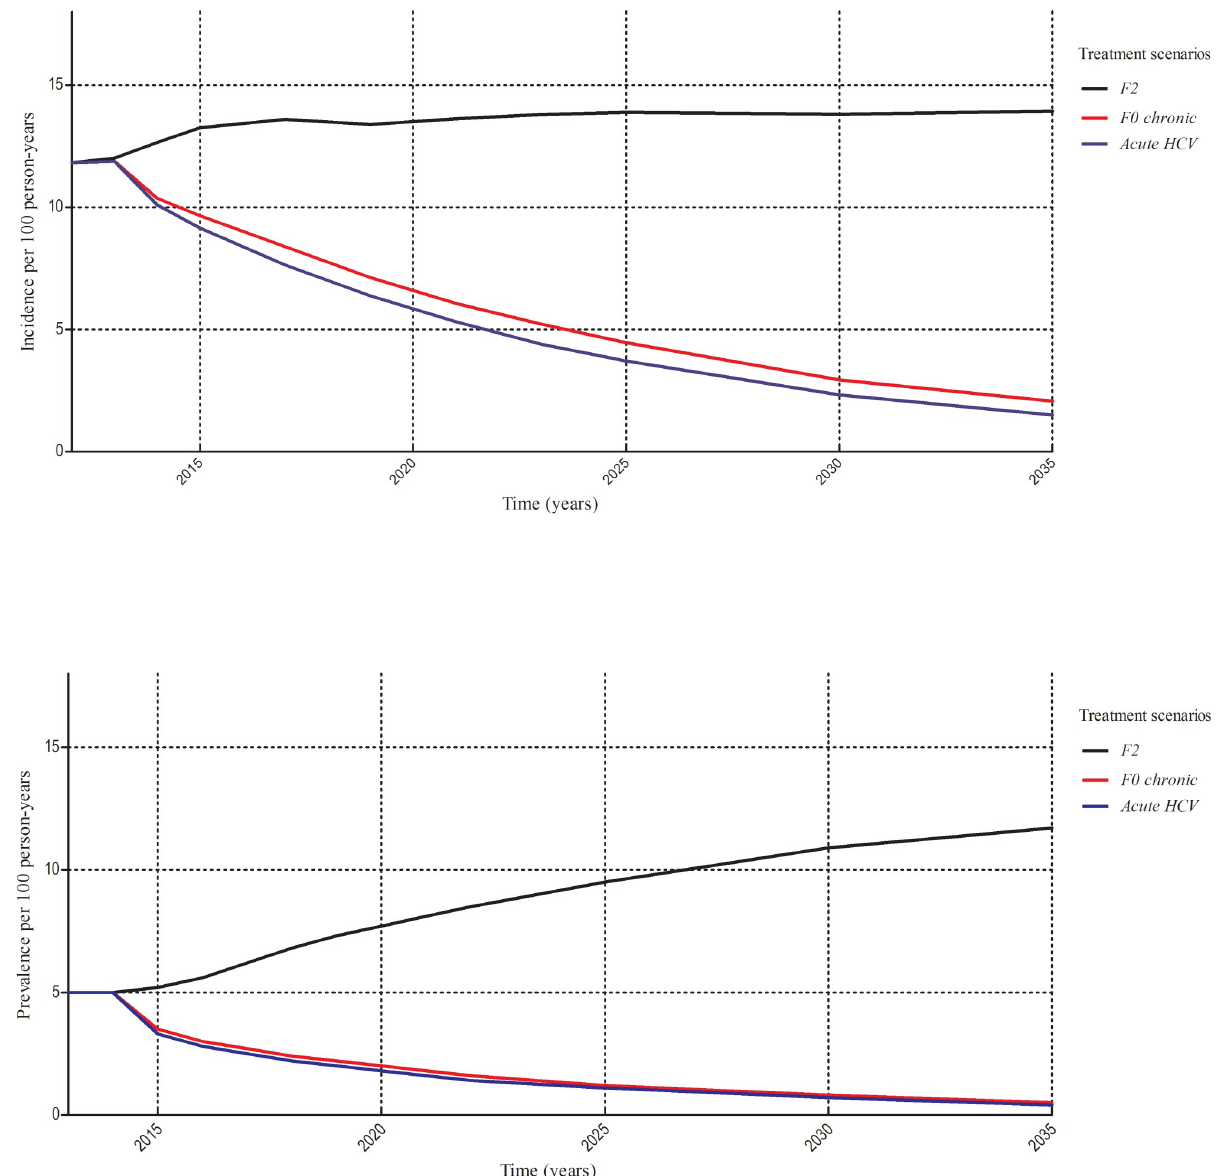
Fig 1. Short term epidemiological hepatitis c virus impact among HIV positive men who have sex with men. In the upper figure, the hepatitis C virus incidence is projected and in the lower figure the hepatitis C virus prevalence. Three different treatment scenarios were simulated over a short term period of 20 years. F2, delaying treatment until a F2 fibrosis stage. F0 chronic, awaiting the time frame of spontaneously clearance. Acute HCV, treatment in the acute stage. Median rates are reported. Abbreviations: HCV = hepatitis C virus.